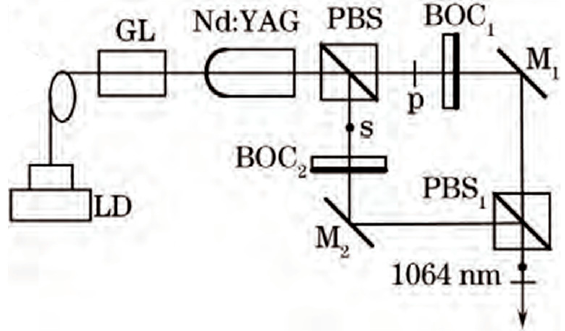
Figure 25. Schematic diagram of dual-frequency Nd : YAG laser system at 1064 nm [35]. LD: laser diode; GL: gradient-index lens; PBS: polarizing beam splitter; BOC: birefringent output coupler; M: mirror.